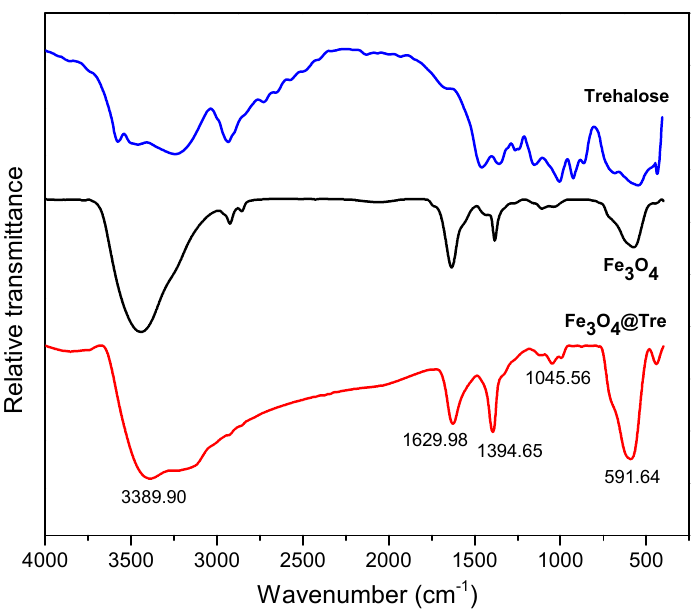
Figure 3. FT-IR spectra of trehalose, bare Fe 3 O 4 NPs, and Fe 3 O 4 @Tre NPs.